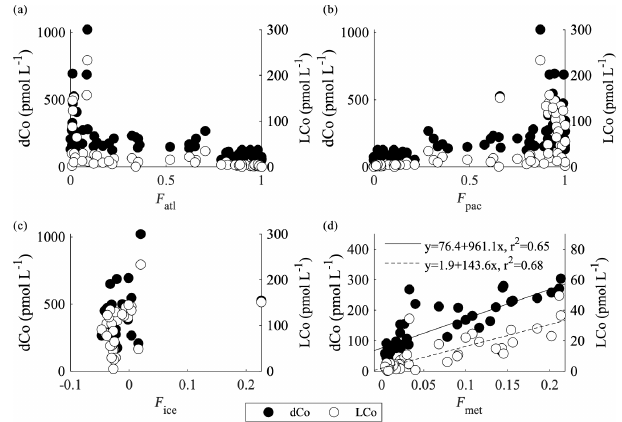
Figure 12. dCo and LCo from select stations versus (a) the fraction of Atlantic water ( F atl ; all stations < 500m), (b) the fraction of Pacific water ( F pac ; all stations < 500m), (c) the fraction of sea ice melt ( F ice ; < 100m and south of 84 ◦ N), and (d) the fraction of meteoric water ( F met ; < 500m and north of 84 ◦